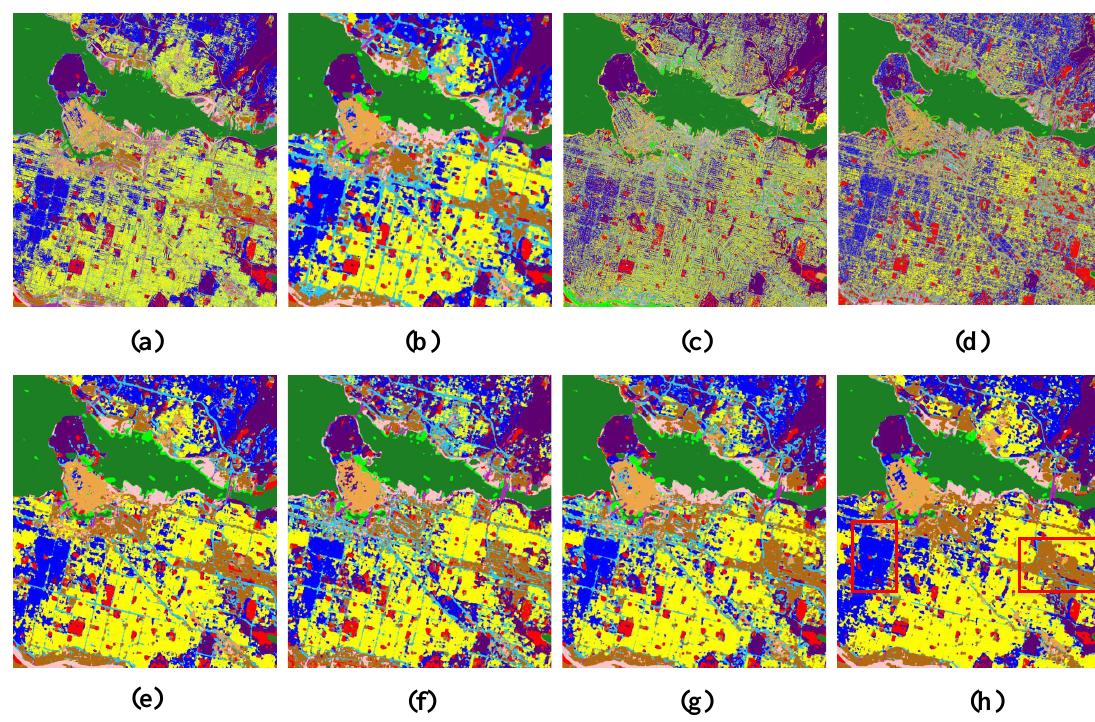
Figure 4. Classification maps with different methods on Level 1B dataset. ( a ) EMAP. ( b ) CAE. ( c ) RNN. ( d ) SCPF-ResNet.